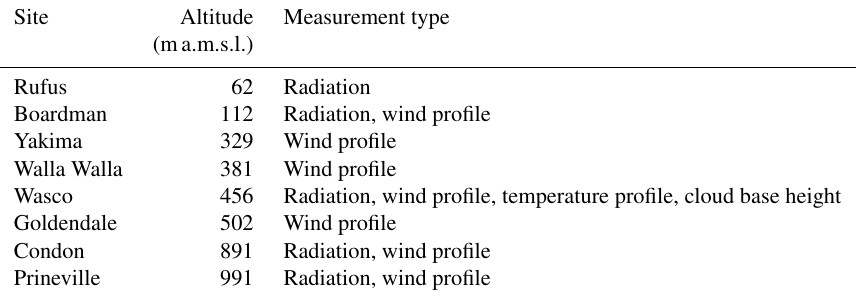
Table 1. Station altitude and measurement types at WFIP2